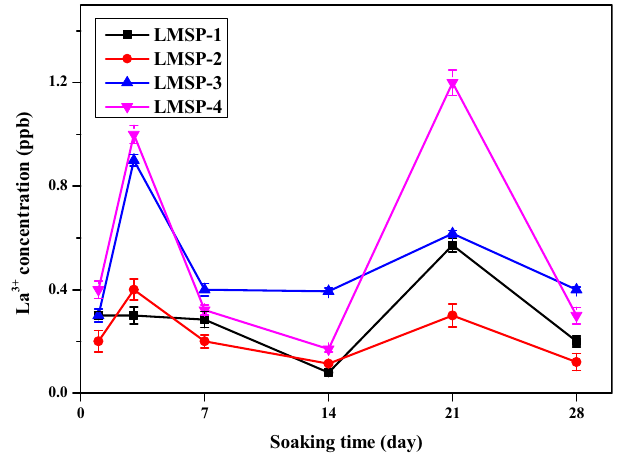
Figure 3. The concentration of La 3+ released from LMSP-1–4 scaffolds in PBS.